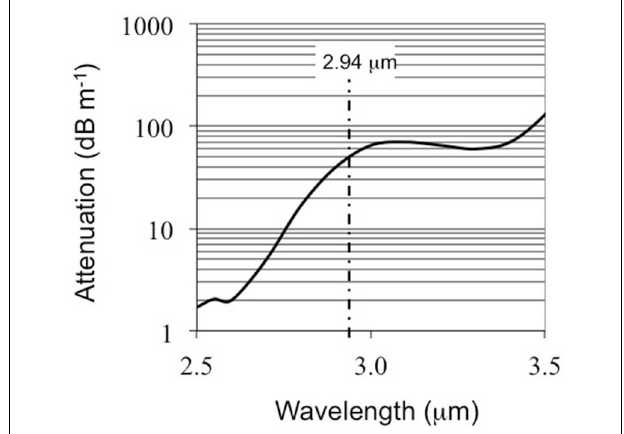
FIGURE 1 | Bulk attenuation for dry silica (Suprasil F300) used for the fabrication of the HC-PCF, from [10].